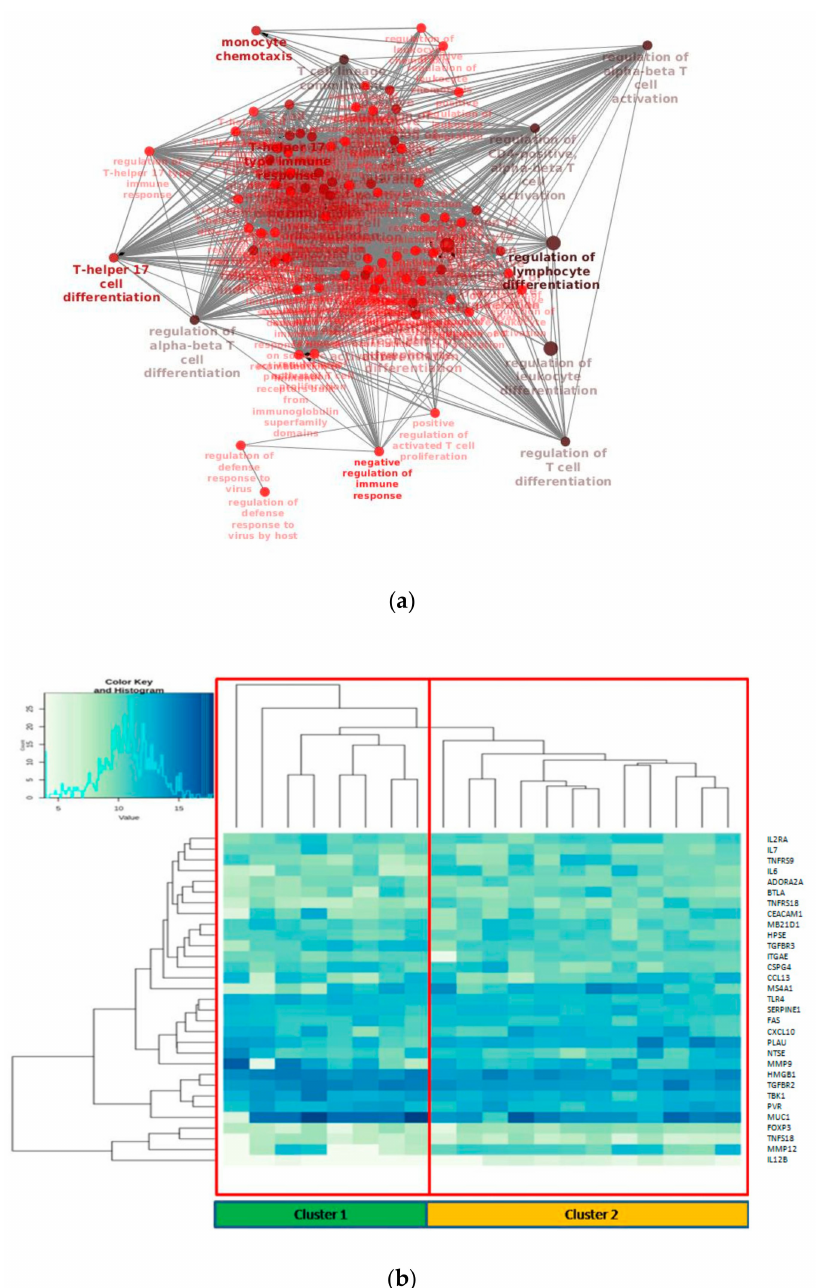
Figure 2. ( a ) Biological network of the enriched GO (Gene Ontology) terms related to di ff erentially expressed genes in the tumor / normal setting; ( b ) Unsupervised hierarchical clustering of the 31 deregulated